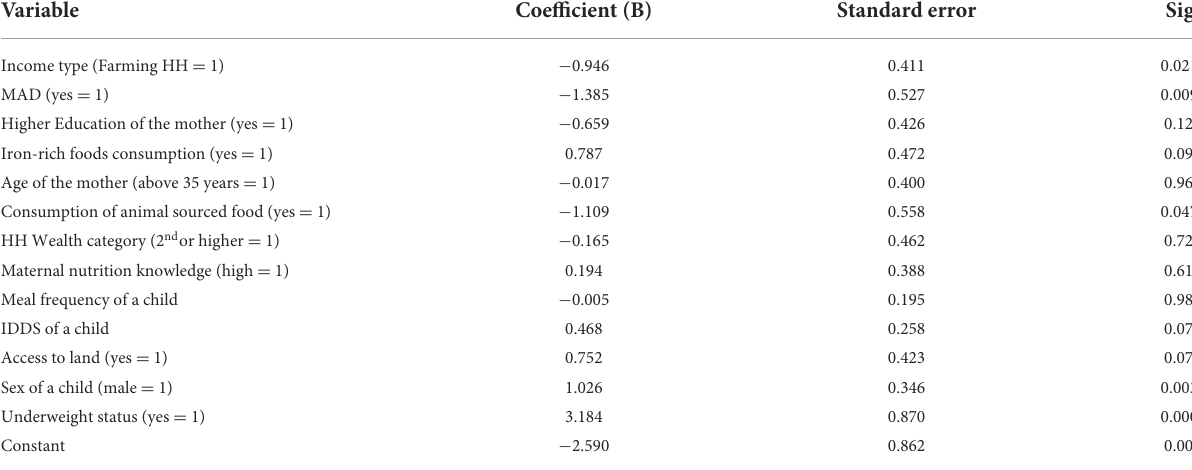
TABLE 7 Determinants of stunting among children aged of 6–23 months. Variable Coefficient (B) Standard error